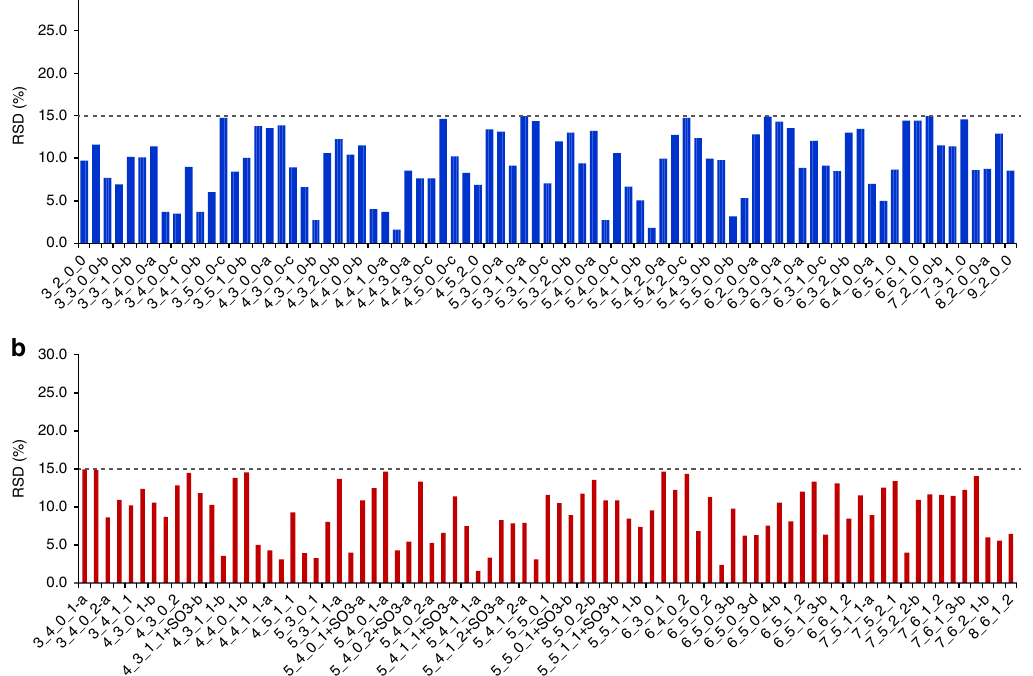
Fig. 1 Quanti fi cation repeatability of N-glycans on HPLC Chip-QQQ MS. The repeatability was shown as the RSD (%) of ten replicate analyses. The RSD of relative abundance of both a neutral and b acidic N-glycans were all